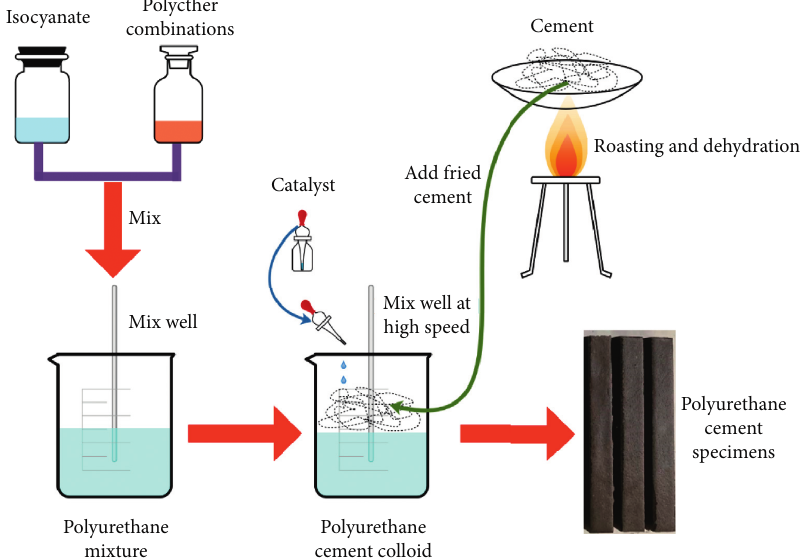
Figure 5: Preparation process of polyurethane